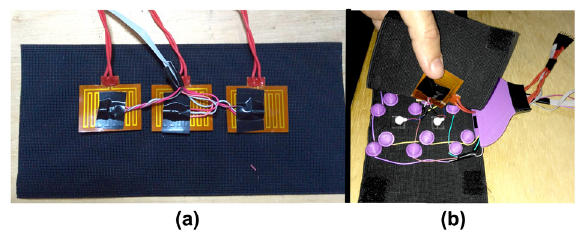
Figure 10: Three fl exible heaters and temperature sensors ( a ) were added to the set of electrodes and motors ( b ) for simulating the temperature of the skin.